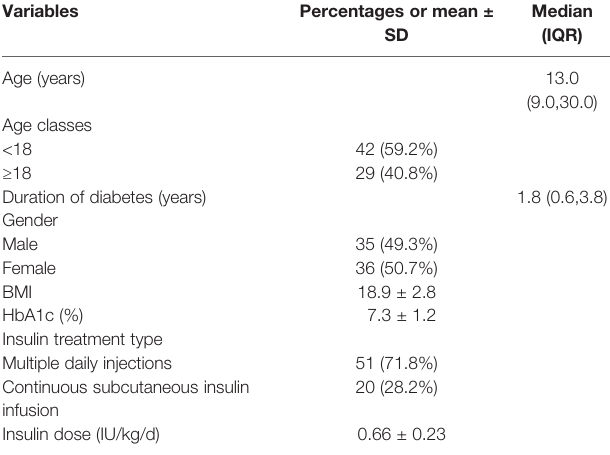
TABLE 1 | Characteristics of study participants (n =